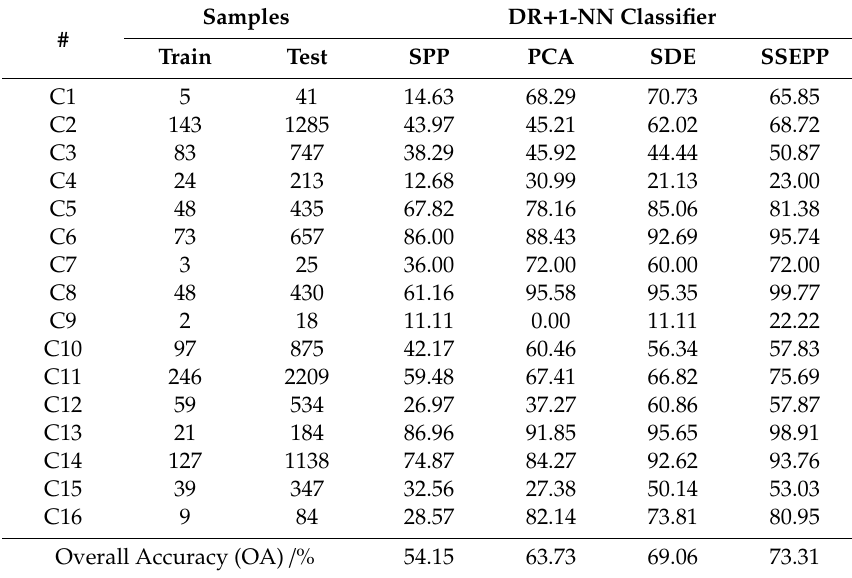
Table 2. Indian Pines classification